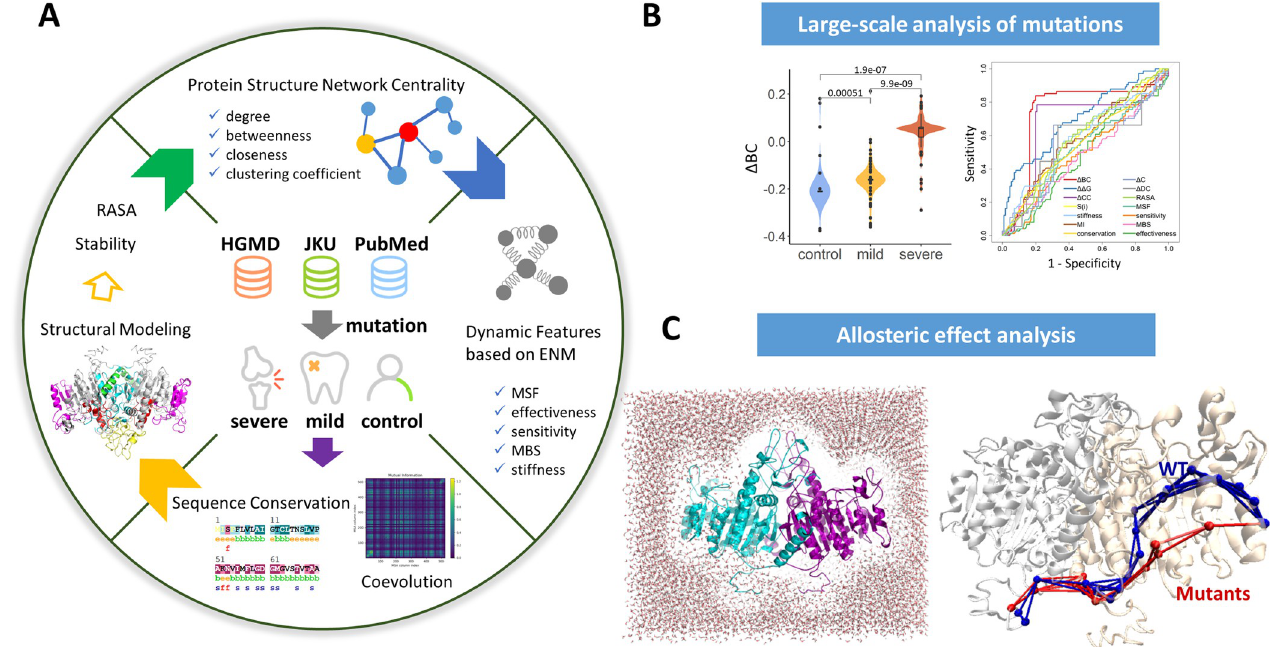
Fig 1. The computational workflow. (A) Beginning with the collection of ALPL mutations associated with different HPP phenotypes and the computational modeling of TNSALP protein structure, molecular signatures of mutational hotspots were calculated. In addition to normally used signatures, three levels of parameters for describing mutations were analyzed: conservation and coevolution analysis at the sequence level, PSN-based network matrices at the structural level, and ENM-related features at the dynamics level. (B) The classification and prediction of pathogenicity of ALPL mutations based on the statistical analysis of molecular signatures and the construction of machine learning models. (C) Allosteric effect analysis of predicted mutations by single-residue perturbation, molecular dynamics and long-range pathway analysis.